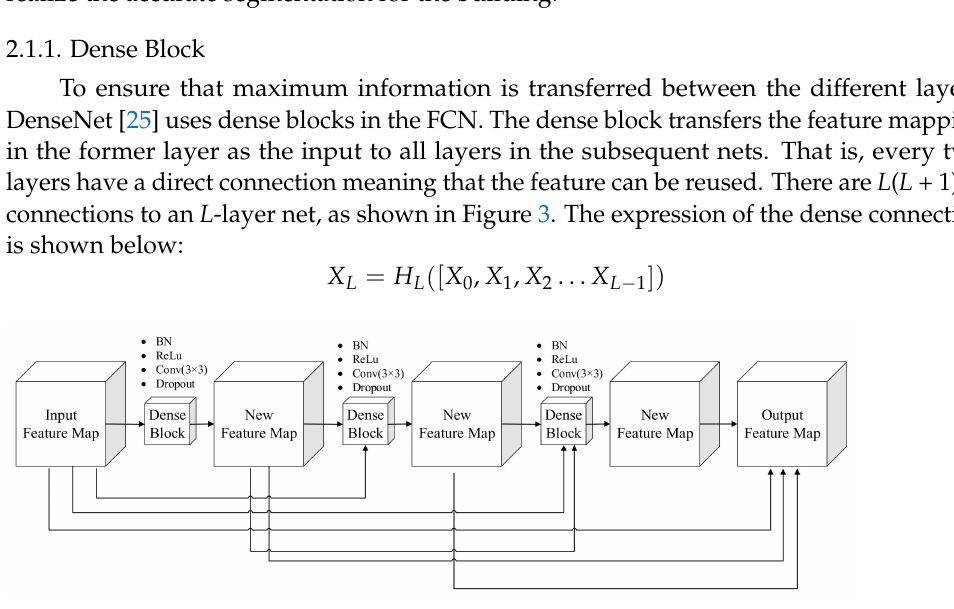
Figure 3. Dense block with three convolutional